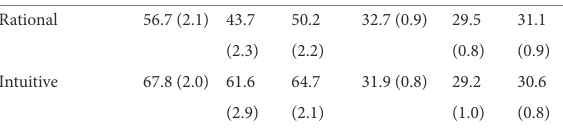
TABLE 5 Total scan path (in degrees) for pictures